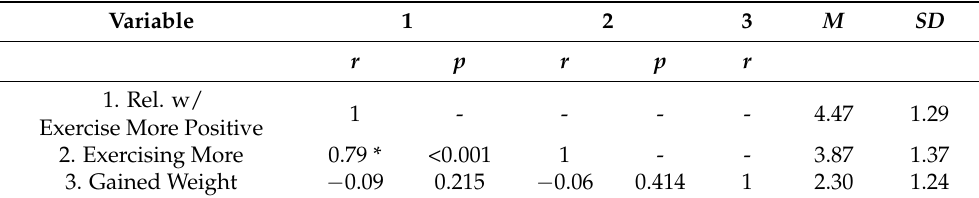
Table 5. Correlations between Observed Variables during COVID-19 Model.